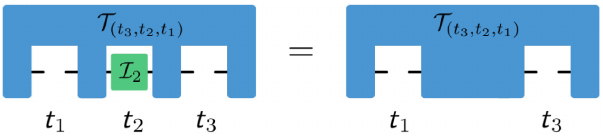
FIG. 23. Consistency condition for quantum stochastic pro- cesses. Letting a process tensor act on an identity (here at time t 2 ) yields the correct process tensor on the remaining times.